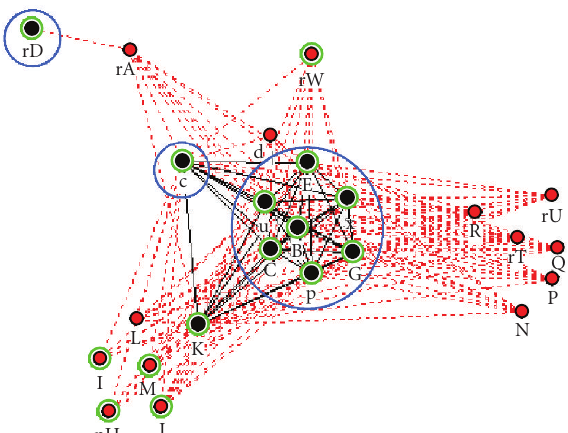
Figure 16: KeyGraph of cluster 3, where c (chat) is one of the keywords on the